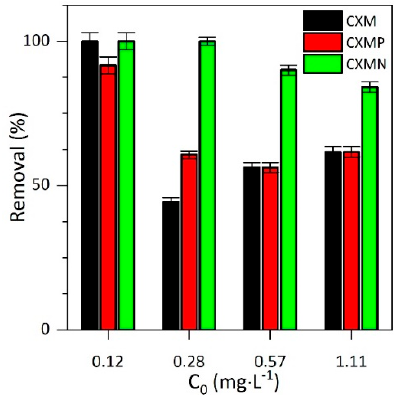
Figure 5. Aflatoxin B1 (AFLA B1 ) removal at 15 min from AFLA B1 solutions at concentrations between 0.1 mg ∙ L − 1 and 10 mg ∙ L − 1 in Na 2 HPO 4 /NaH 2 PO 4 buffer at pH = 7.4 using carbon xerogel microspheres (CXMs) and CXMs functionalized with melamine (CXMN) and phosphoric acid (CXMP) at 37 °C.